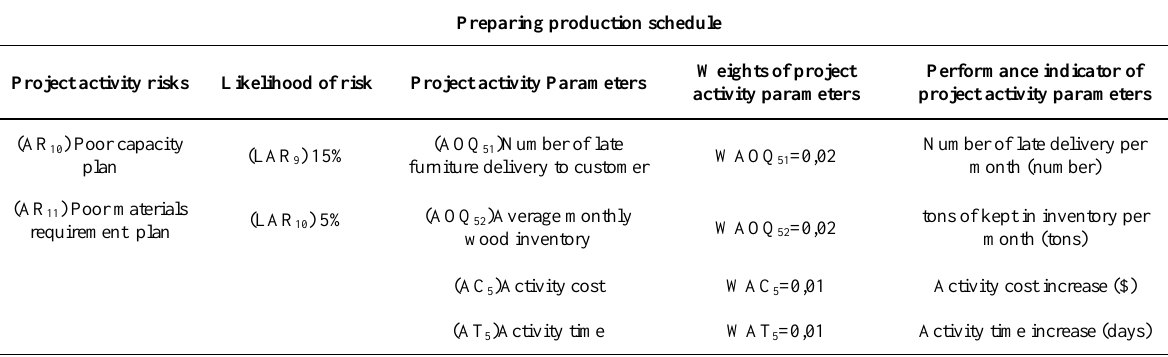
Table 6. TOPSIS information table of preparing production schedule.